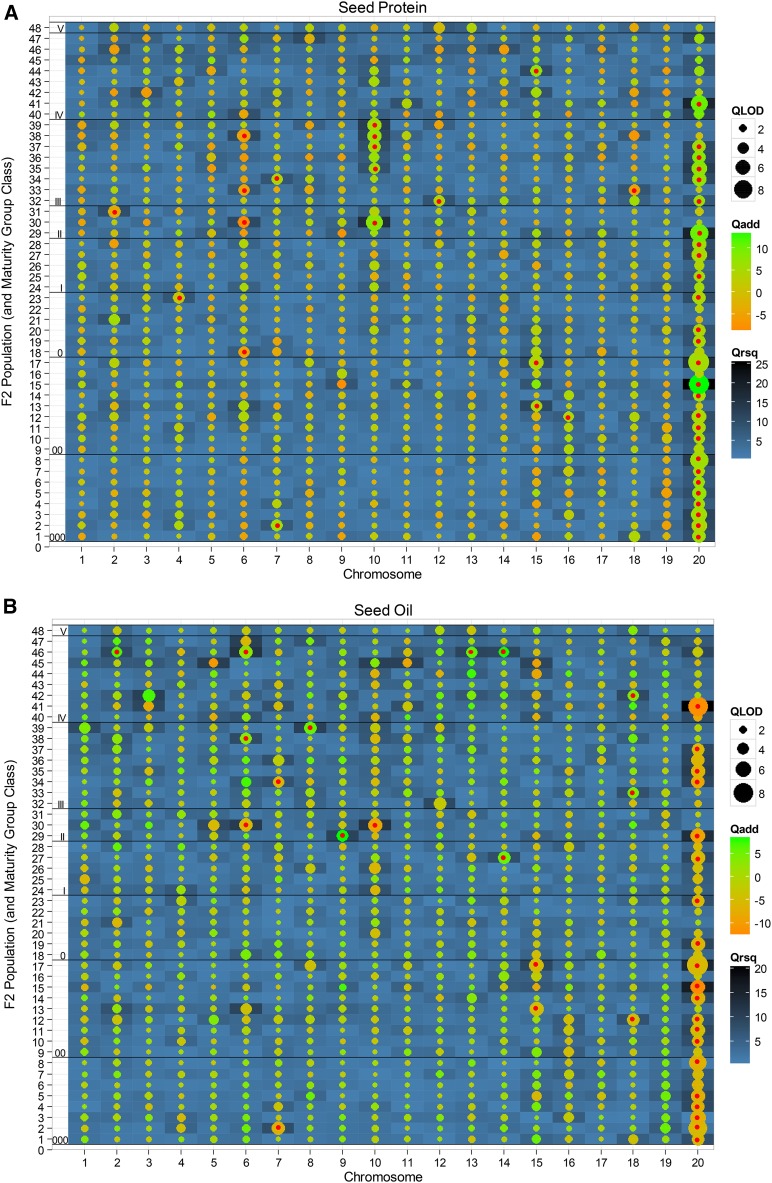
A heat map depicting parameter estimates for the SG-detected QTL for protein (A) and oil (B). The 48 MG-class matings are listed on the left axis, and 20 soybean chromosomes on the horizontal axis. The LOD score peak magnitudes are denoted by bubble size; those exceeding a genome-wise α = 0.05 significance threshold derived from trait- and population-specific SG-stratified permutation tests (n = 1900) have red dot centers. Additive effect magnitude is denoted by bubble color intensity; green denoting a positive and orange a negative directional effect of the female parent B allele. The magnitude of the R2 values is denoted by square tile color (light blue to deep black). See Table S4 for numerical values of QTL analysis parameters and permutation values.